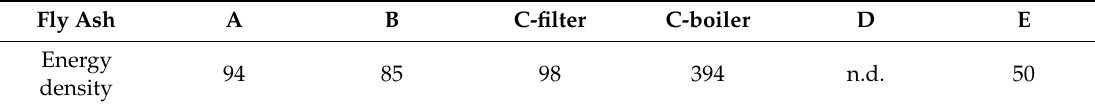
Table 7. Energy content based on DSC signal in N 2 atmosphere for each fly ash (in kJ/kg). Fly Ash A B C-filter C-boiler D E Energy density 94 85 98 394 n.d. 50 The measured energy content of fly ash C-boiler (394 kJ/kg) is not negligible in comparison with potential metal oxide candidates at high temperatures, such as Co 3 O 4 /CoO, CuO/Cu 2 O, Mn 2 O 3 /Mn 3 O 4 , and MnO 2 /Mn 2 O 3 with energy content values of 844, 810, 202, and 480 kJ/kg,